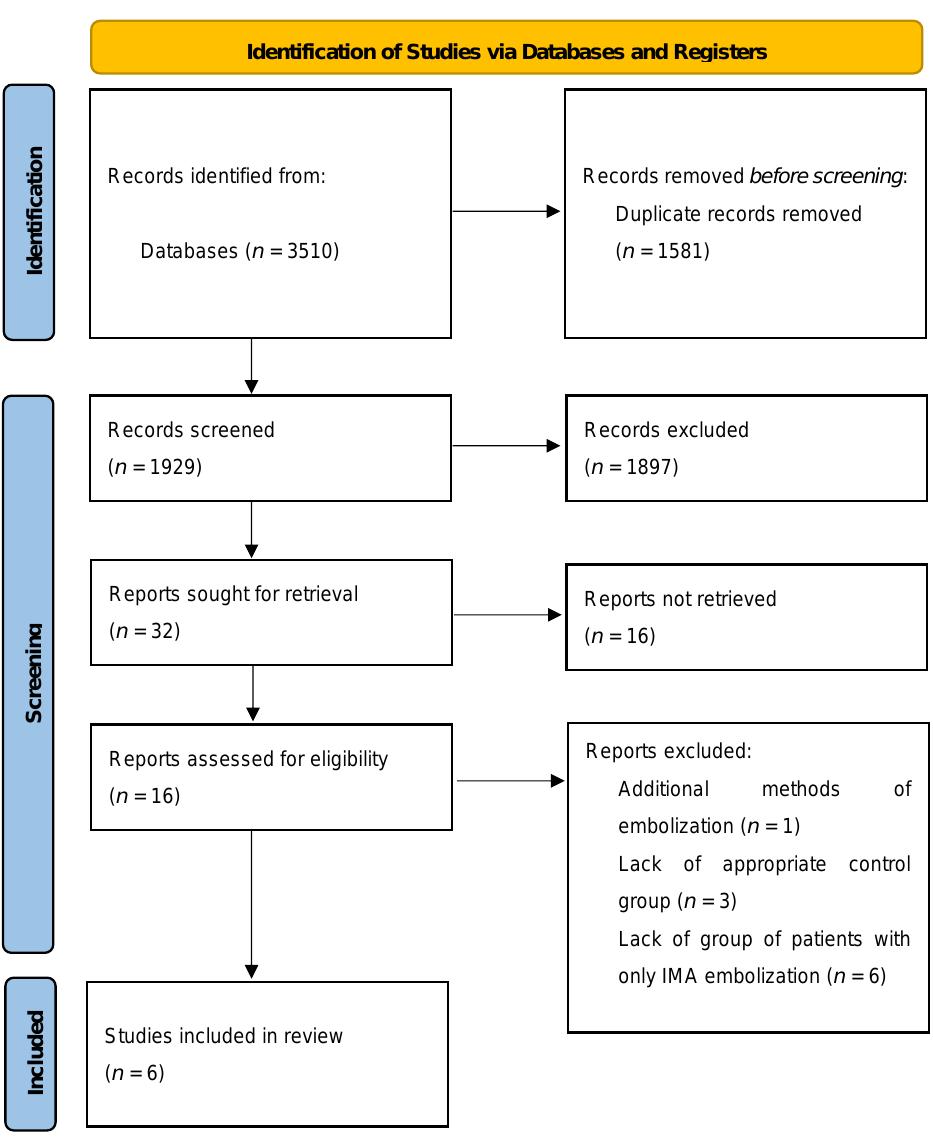
Figure 1. PRISMA 2020 flow diagram for new systematic reviews which included searches of databases only. PRISMA, Preferred Reporting Items for Systematic Reviews and Meta-Analyses.